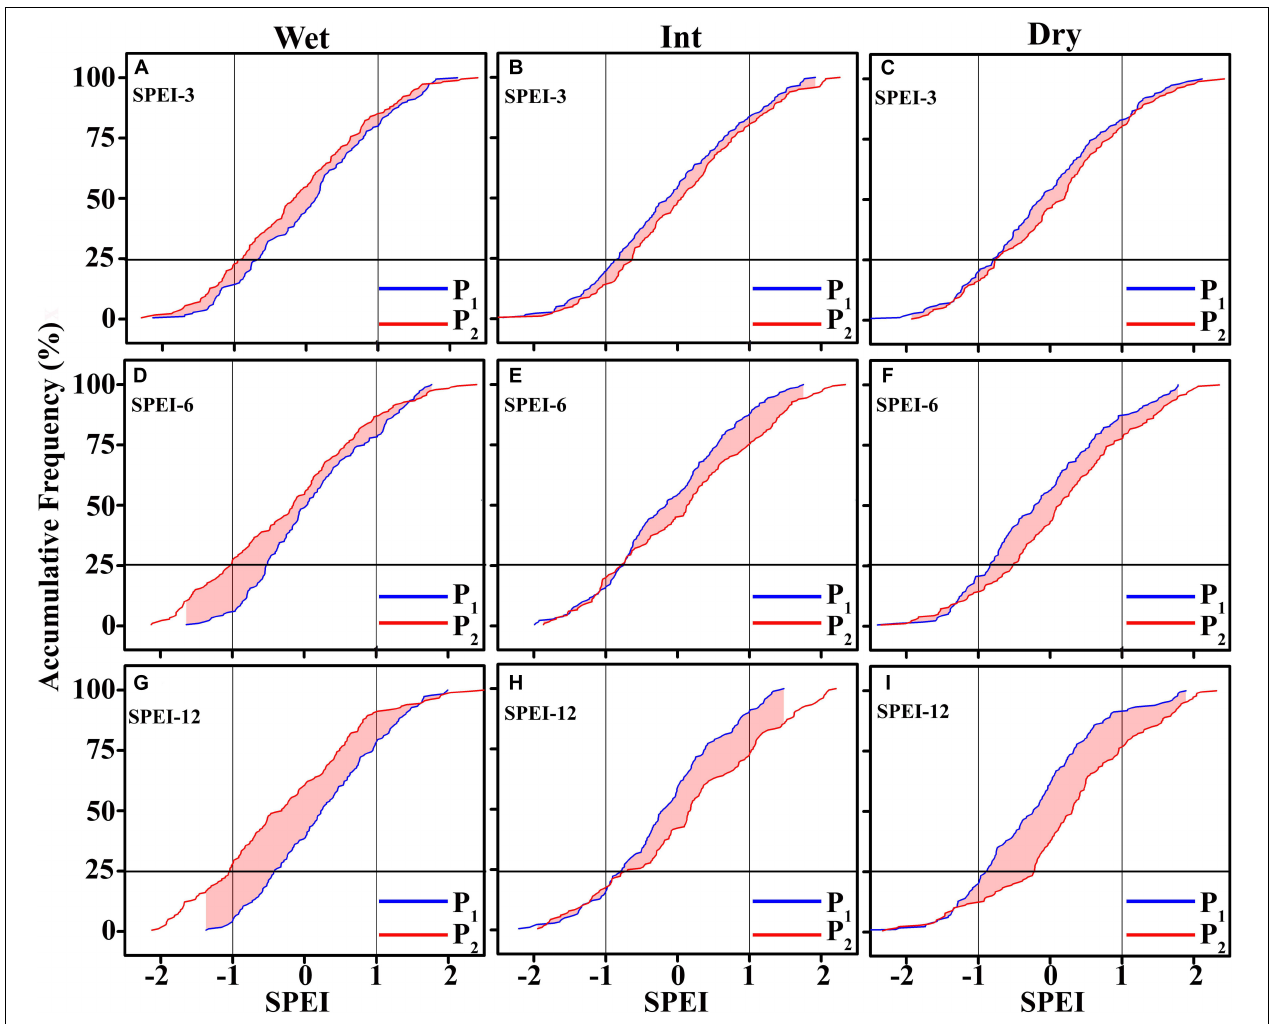
FIGURE 5 | Accumulative frequency distributions of short-term drought (SPEI-3 < –1) for (A) wet, (B) intermediate, and (C) dry regions in Mahaweli river basin (MRB) during early (P 1 ; 1985–1999; Blue line) and late (P 2 ; 2000–2015; Red line). The middle (D–F) and lower (G–I) panels are the same as top panels but for the medium-term (SPEI-6 < –1), and long-term (SPEI-12 < –1) droughts, respectively. The value below –1 (above + 1) is selected as the threshold level for the drought (wet) event.